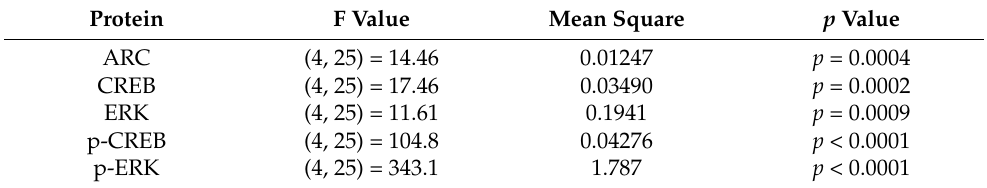
Table 4. Table for ANOVA results for expression levels of proteins 10 min after ketamine